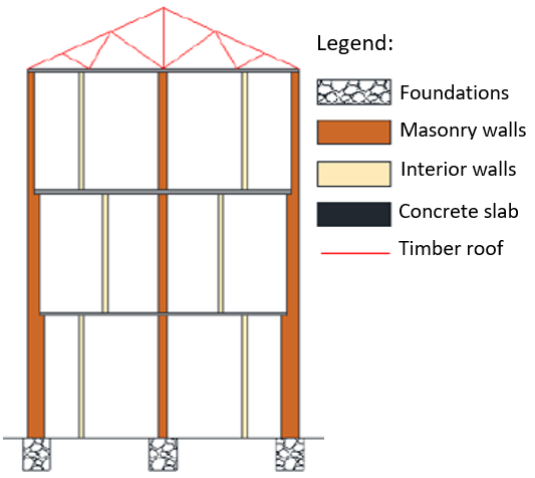
Figure 1. Scheme of "Placa" building